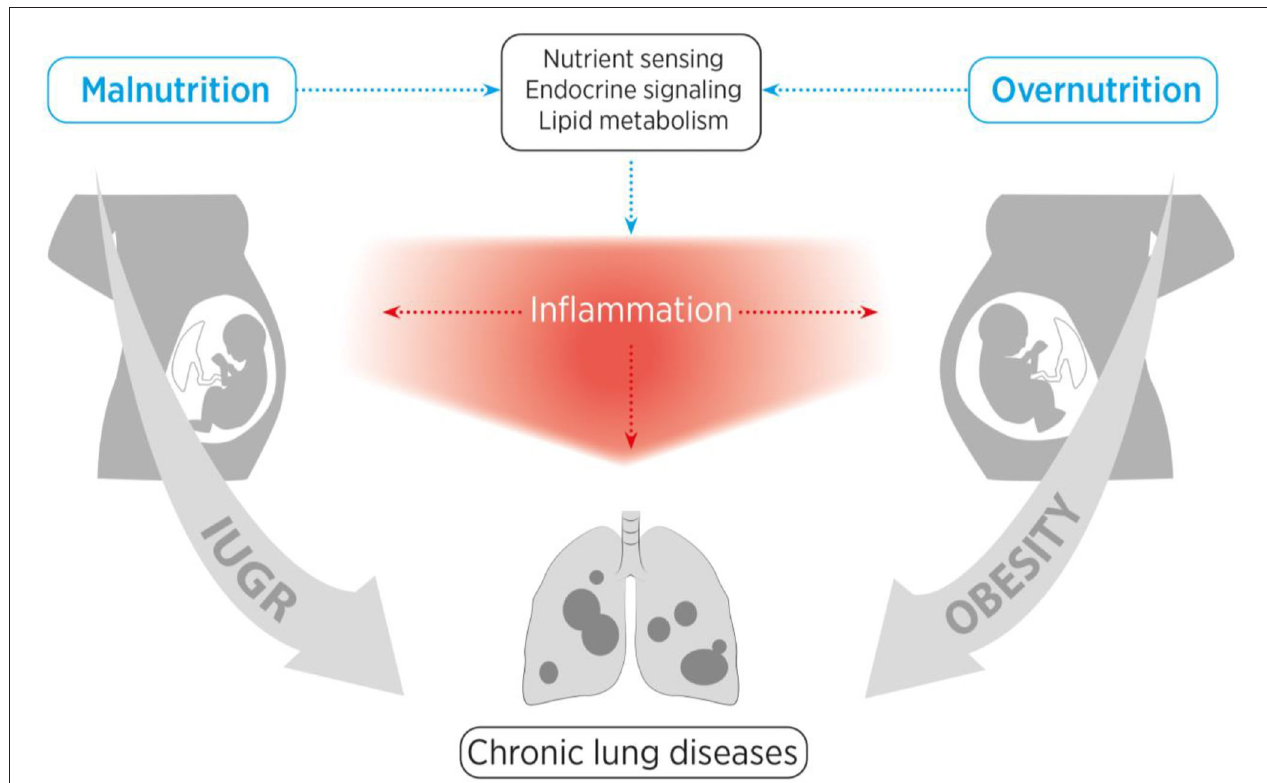
FIGURE 1 | Schematic representation of the structure of this review. We aim to provide a comprehensive overview of the influences of maternal obesity, early childhood obesity and intrauterine growth restriction (IUGR) on nutrient sensing as well as endocrine and inflammatory pathways, and how these adverse perinatal effects contribute to the early origins of chronic lung